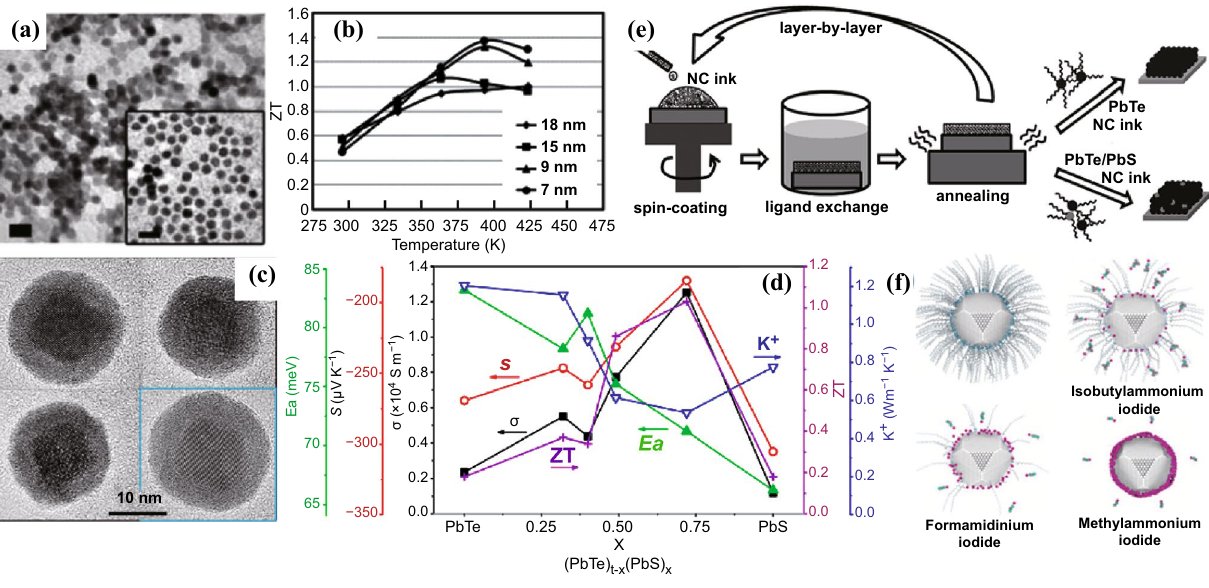
Fig. 4 a TEM image of colloidal PbSe QDs after metal chalcogenide complex treatment with a diameter of 9 nm. b ZT of the prepared PbSe(SnS 2 ) QD films versus temperature. c HRTEM graphs of a few (PbTe) 0.25 @(PbS) 0.75 core–shell nanoparticles. d σ , S , porosity-corrected κ , and ZT at 710 K and activation energy for electrical transport in the low-temperature range (E a ), as a function of the PbS concentration in the core–shell (PbTe) 1− x (PbS) x nanoparticles. e Synthesis of colloidal nanocrystal thin films by layer-by-layer method and strategy for optimizing TE performance. f Schematic of oleic acid ligand exchange using different iodide salts. Adapted with permission from Refs.